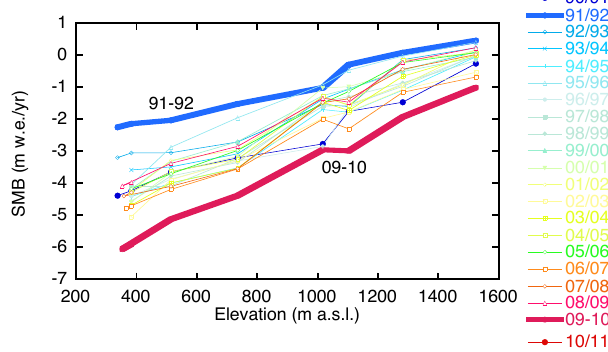
Figure 4: Surface mass balance as a function of elevation for each individual year starting in 1990. The lowest surface mass balance was recorded the second year and the highest during the season 2009–2010; both are indicated with thick lines.